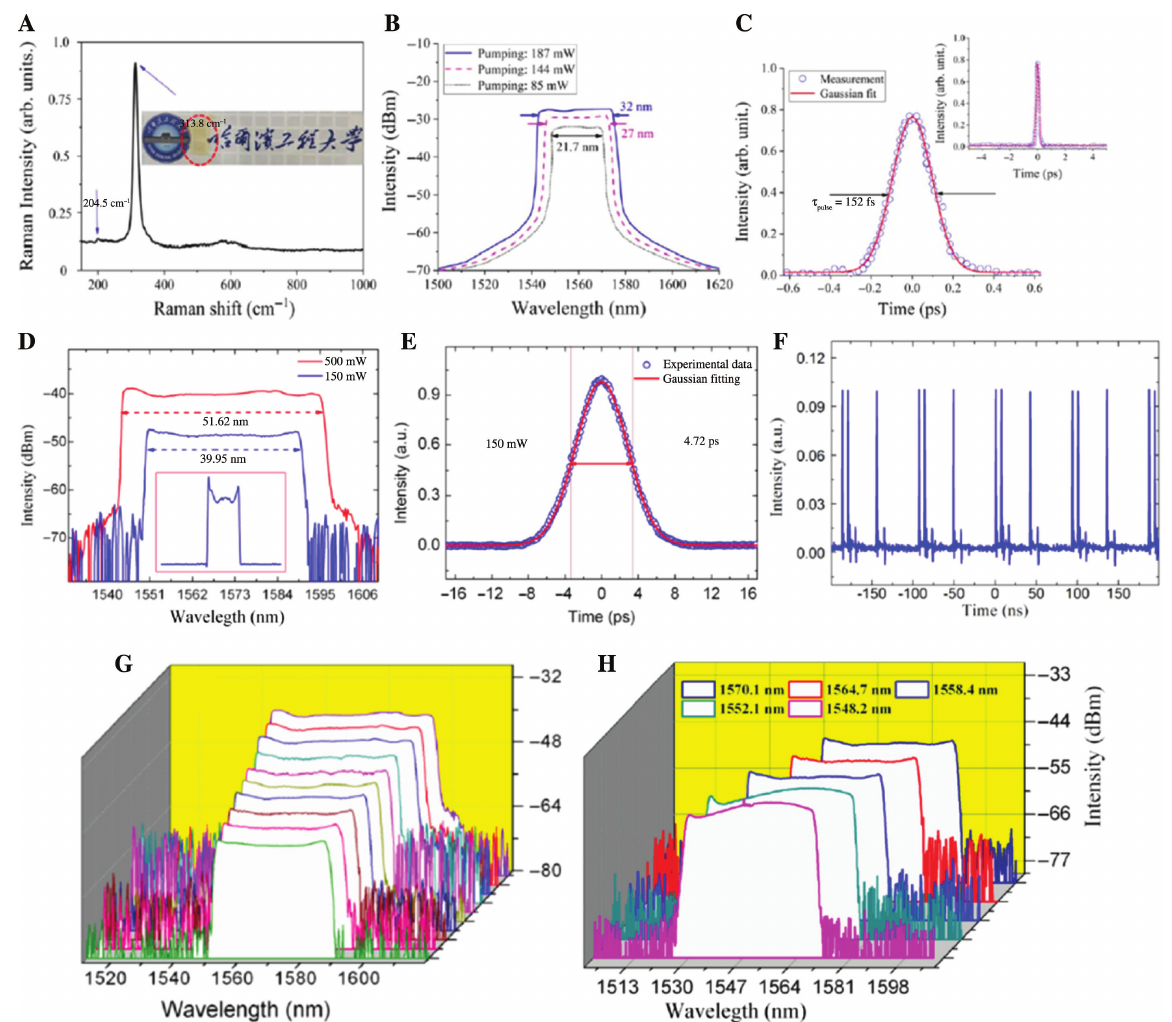
Figure 15: High-performance mode-locked fiber lasers with various SA. (A–C) SnS . (A) Raman spectrum of SnS 2